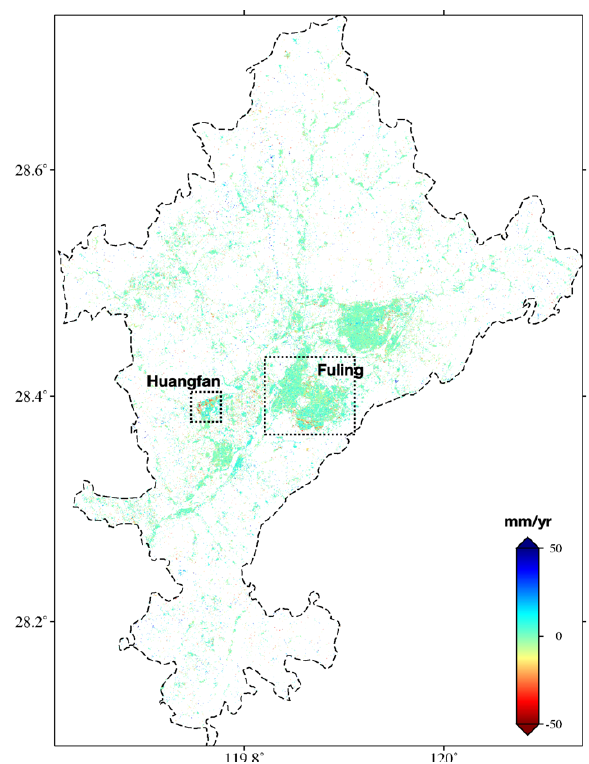
Figure 2 . Subsidence velocity of Lian District, Central Lishui during 2019 –